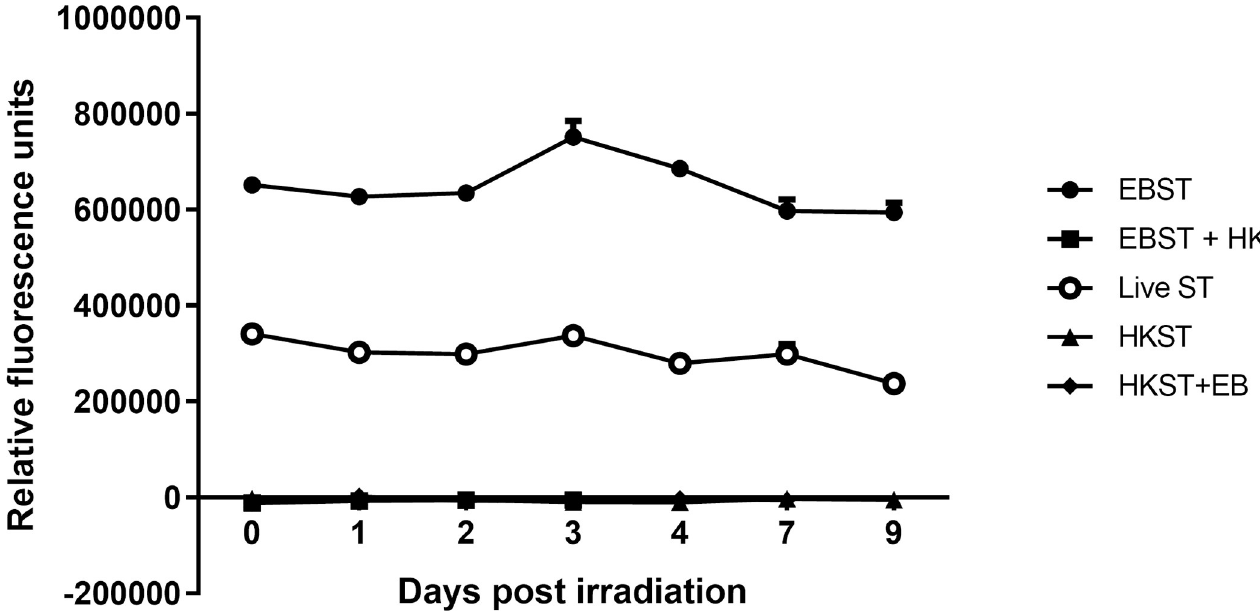
Fig 5. EBST remains metabolically active and retains the activity for extended time periods of storage at 4˚C. Metabolic activity of S . Typhimurium post eBeam irradiation was measured using Alamar blue assay. The reduced environment present in metabolically active cells are detected by redox indicator which fluoresces. The fluorescence readings obtained for EBST, live ST and heat killed ST (HKST) was measured on a daily basis up to 9 days and are reported as line graph. Metabolic activity of EBST cells followed by heat inactivation (EBST+HK) and HKST followed by eBeam irradiation (HKST+EB) were measured as process controls.